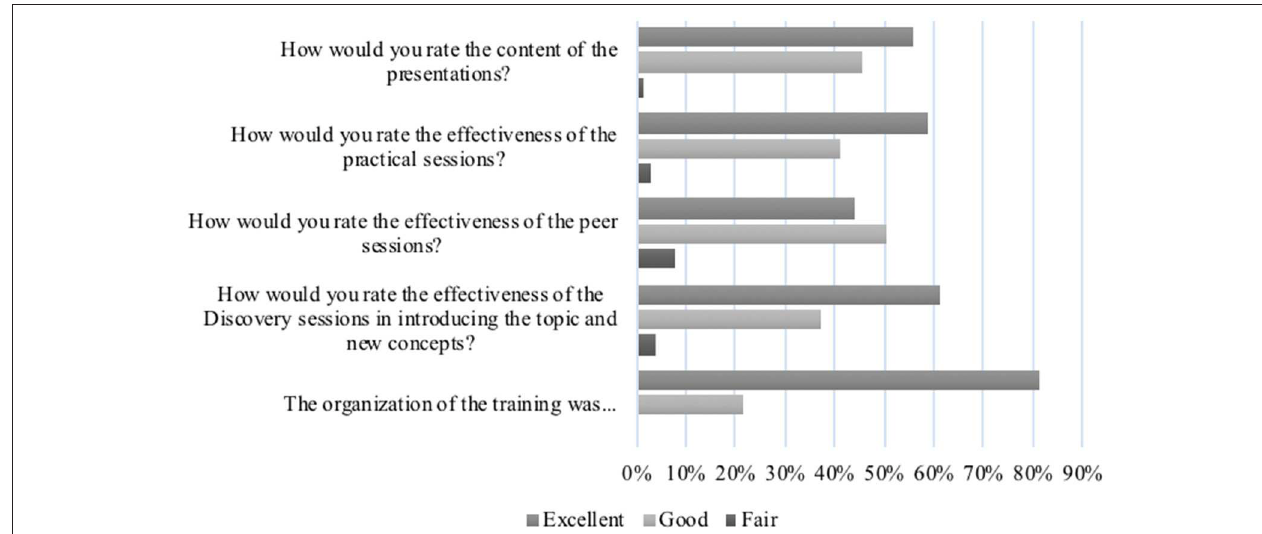
FIGURE 1 | Participant evaluation of the pedagogical approaches to the course (2017–2019).